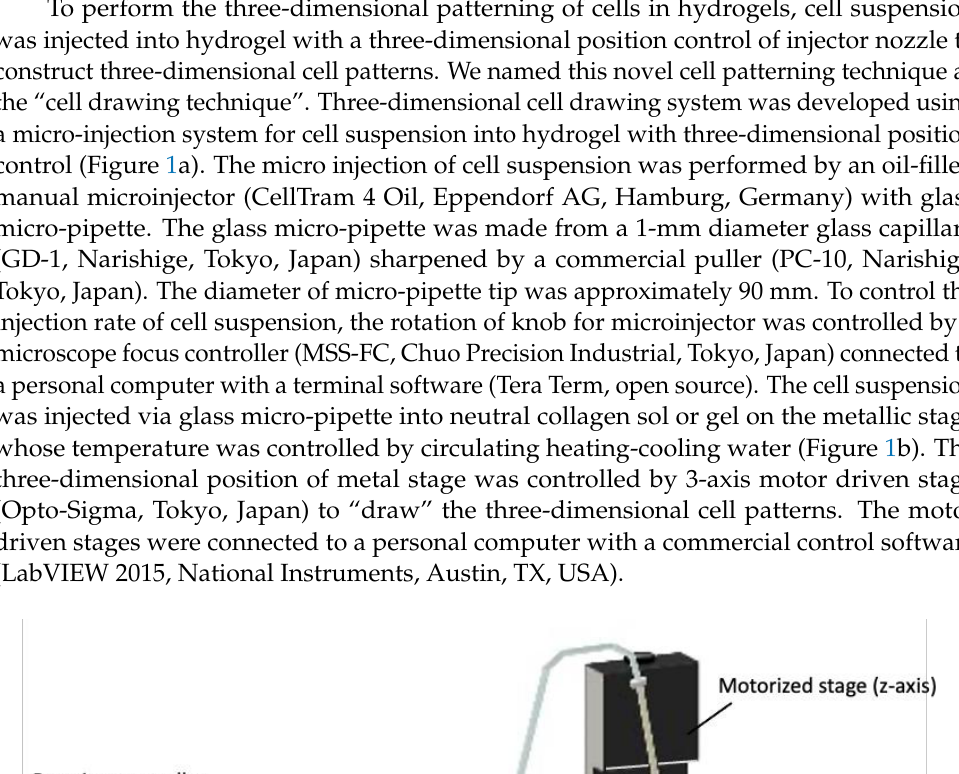
( b ) Figure 1. Micro-injection and three-dimensional position control system for three-dimensional cell drawing. ( a ) Experimental setup consisting of micro-injector and 3-axis motorized stages, ( b ) tem- perature control of system for collagen sol/gel. 2.2. Cell Culture PC-12 cells (neuron-like cell line; Riken Bioresource Center, Tsukuba, Japan) was used to reconstruct neuronal-like network in a collagen gel. PC-12 cells were cultured in Dulbecco ’ s Modified Eagle Medium (DMEM) with 10% horse serum (HS) and 10% fetal bovine serum (FBS) to prepare sufficient cell number for the three-dimensional cell draw- ing experiments. For the cell drawing experiments, the cells were suspended in a fresh culture medium at a concentration of 1 × 10 6 cells/mL. After injection into the collagen gel, the cells were cultured in DMEM + 10% HS + 10% FBS + 5 nM Nerve Growth Factor (mNGF 2.5S, Alomone Labs, Jerusalem, Israel) to induce neuronal differentiation. 2.3. Verification of Collagen Gel Types for Scaffold Material System To determine an appropriate collagen gel type for the three-dimensional cell injec- tion, native collagen and atelocollagen were tested for the hydrogel material. Type I acid- soluble collagen (IAC-30, Koken, Tokyo, Japan) and type I pepsin-solubilized collagen (IPC-30, Koken, Tokyo, Japan) in acidic solutions at 3.0 mg/mL were used as native colla- gen and atelocollagen, respectively. 2.4 mg/mL neutralized collagen solution was pre- pared from the 3.0 mg/mL acidic collagen solution and poured into a f 100 petri dish to form a collage gel with 2.0 mm of thickness. The neutralized collagen solutions in petri dishes were gelled at 37 °C for 20 min on the metallic stage of cell-drawing system.